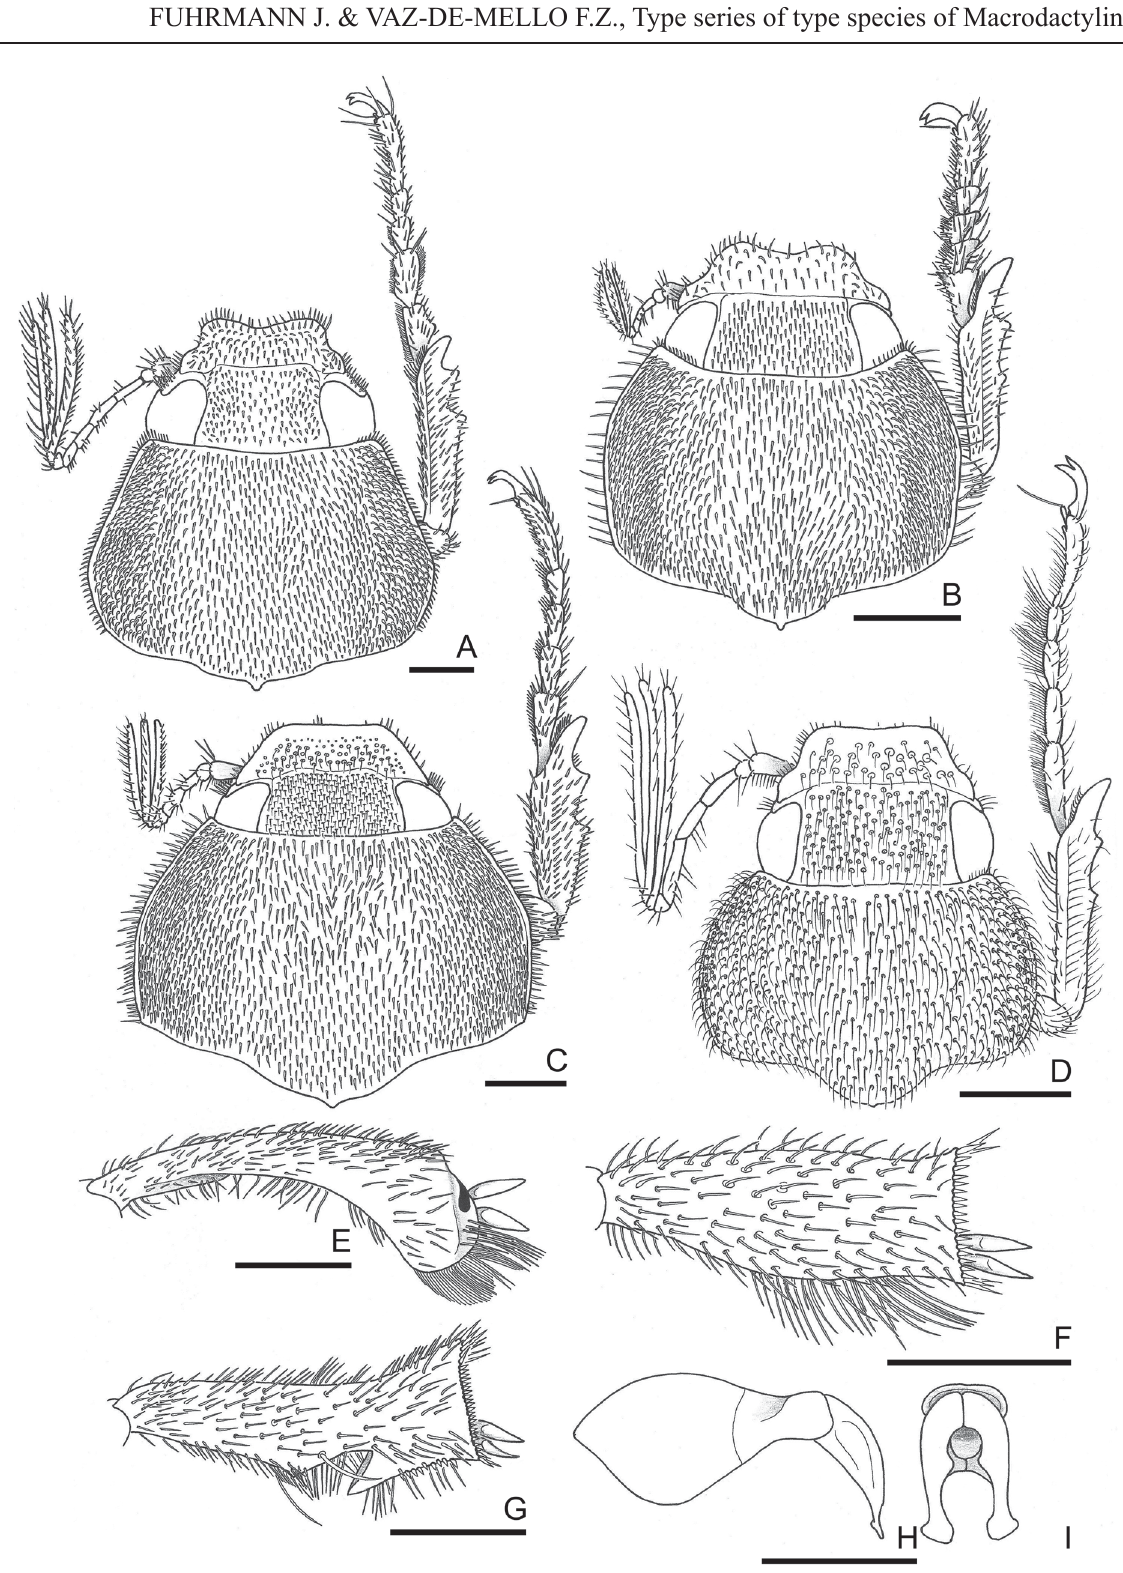
Fig. 2. ♂♂. A–D . Head–prothorax dorsal, tarsus rotated laterally to apex. E–G . Metatibia. H–I . Aedeagus (lateral, parameres apex). A , E . Agaocnemis pruina Moser, 1918. B , F , H–I . Byrasba volvula (Burmeister, 1855). C , G . Hamatoplectris caracana Frey, 1969. D . Hieritis macrocera Burmeister, 1855. Scale bars = 1